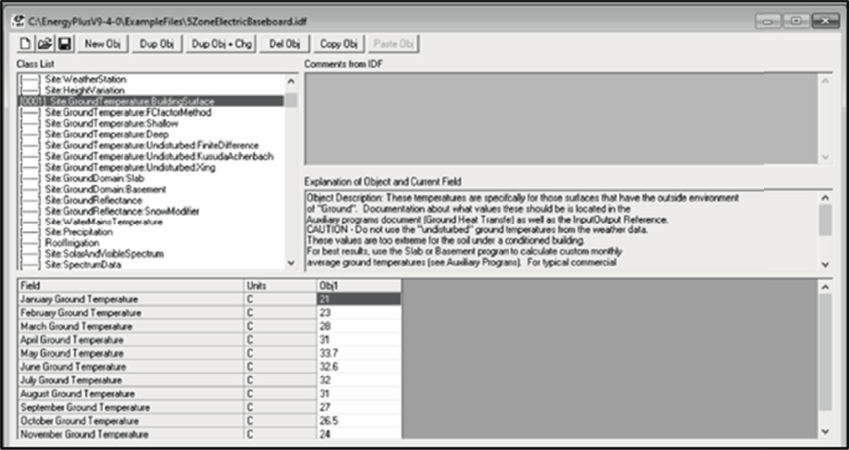
Figure 5: Selection and parameter feeding of site location.